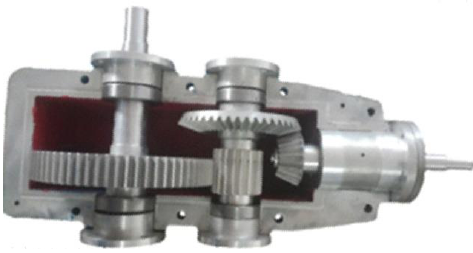
Figure 2. Parts recognition from assembled products.